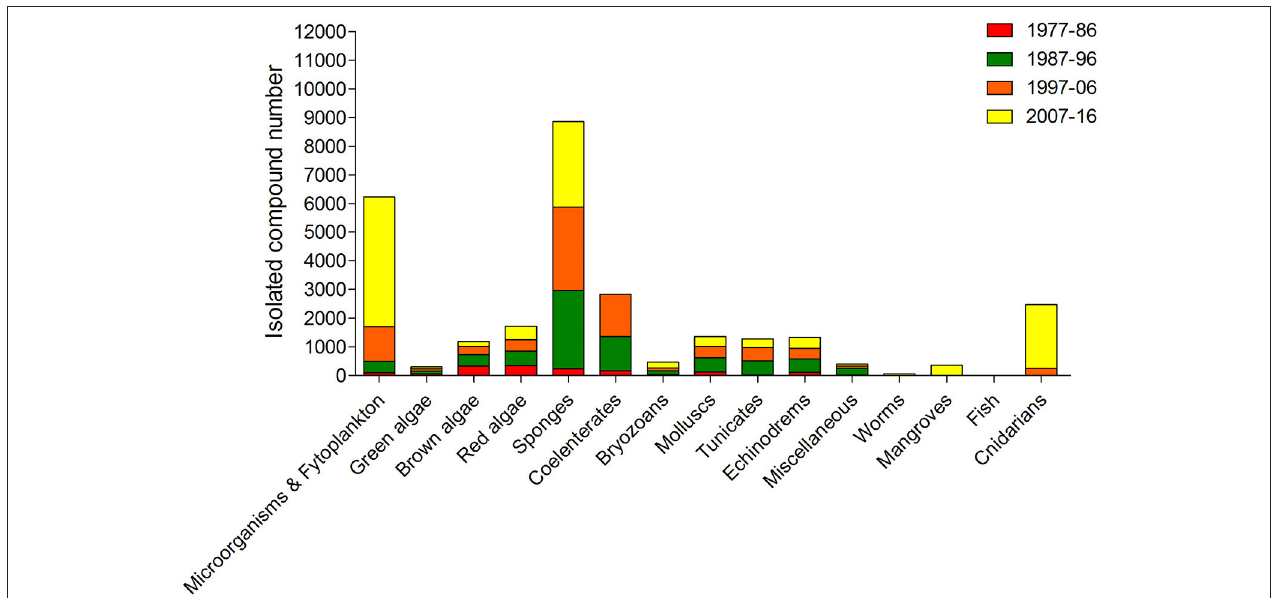
FIGURE 4 | Approximate numbers of new compounds isolated from different marine organism sources between 1977 and 2016 (Faulkner, 1984, 1986, 1987, 1988, 1990, 1991, 1992, 1993, 1994, 1995, 1996, 1997, 1998, 1999, 2000, 2001, 2002; Blunt et al., 2003, 2004, 2005, 2006, 2007, 2008, 2009, 2010, 2011, 2012, 2013, 2014, 2015, 2016, 2017, 2018).